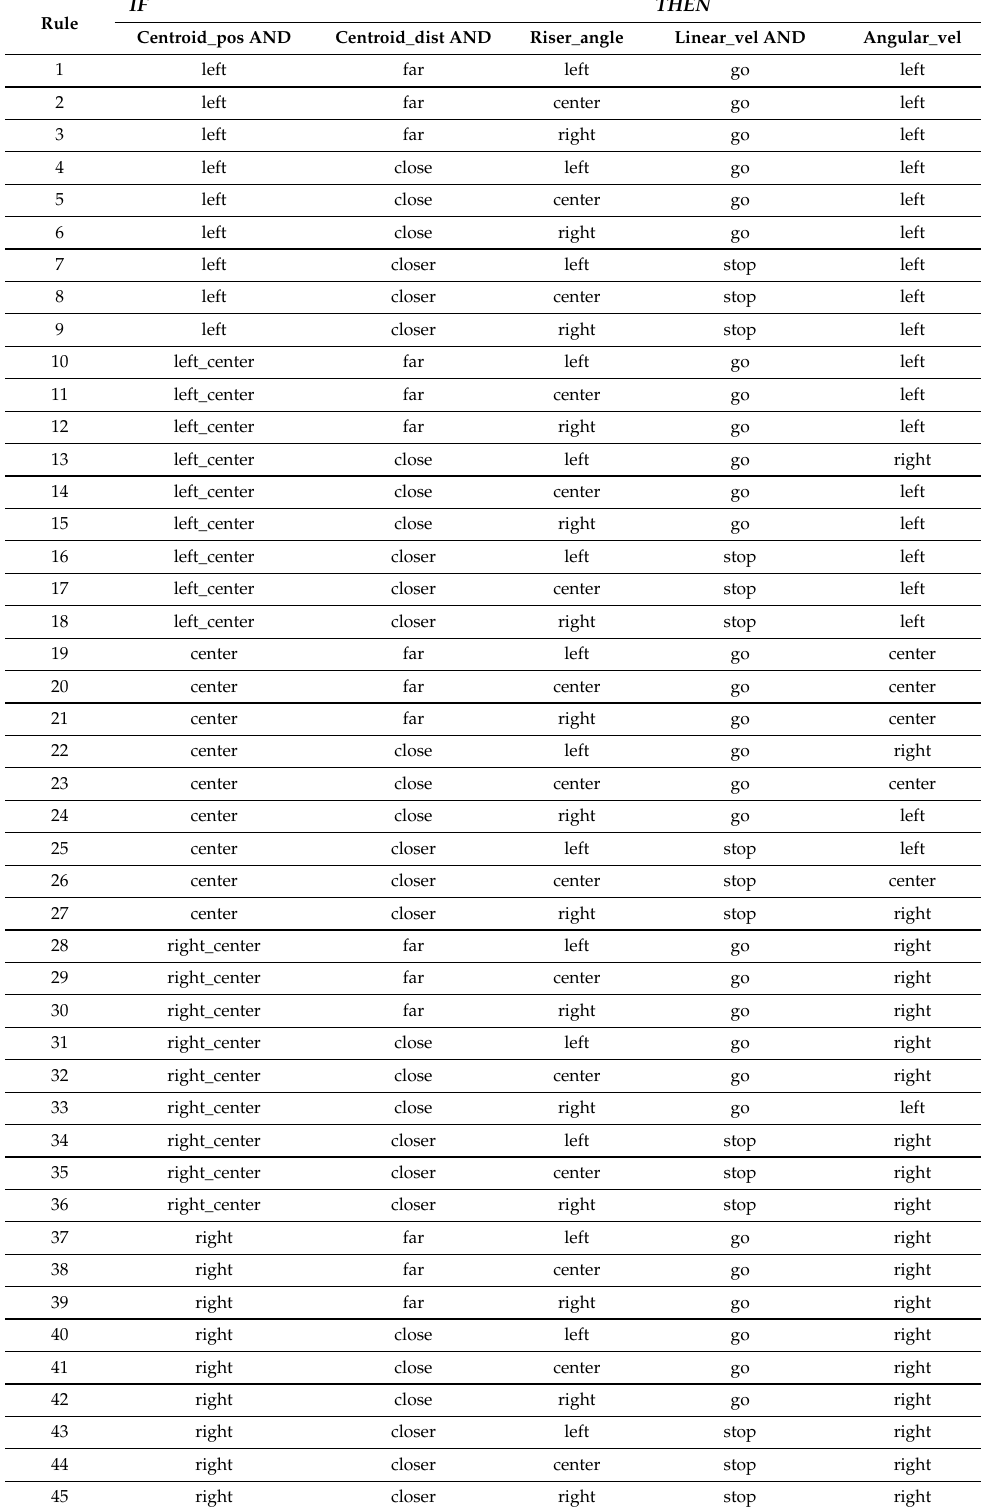
Table A1. Fuzzy rules used for the staircase